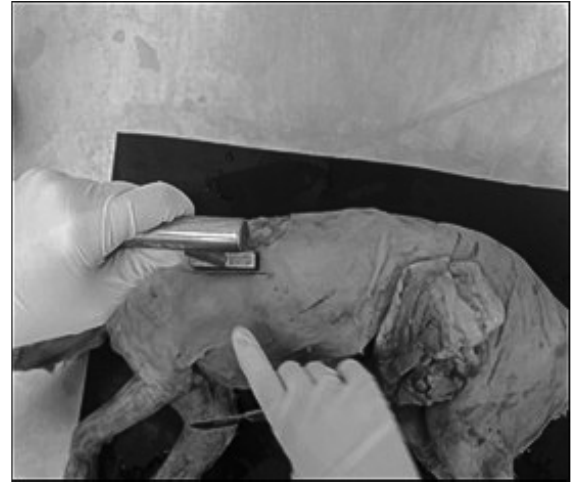
Figure 1. Cat positioned in right lateral decubitus to collect three samples of the skin parallel and 5cm from the median line on the chest.